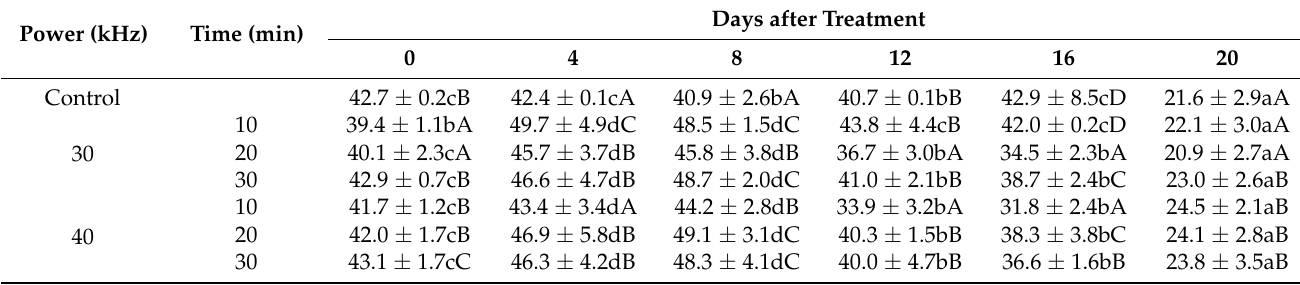
Data expressed as mean ± standard deviation of three repetitions. In the same row, different lowercase letters indicate statistically significant differences between treatment days ( p < 0.05). In the same column, different capital letters indicate statistically significant differences between the treatments ( p <